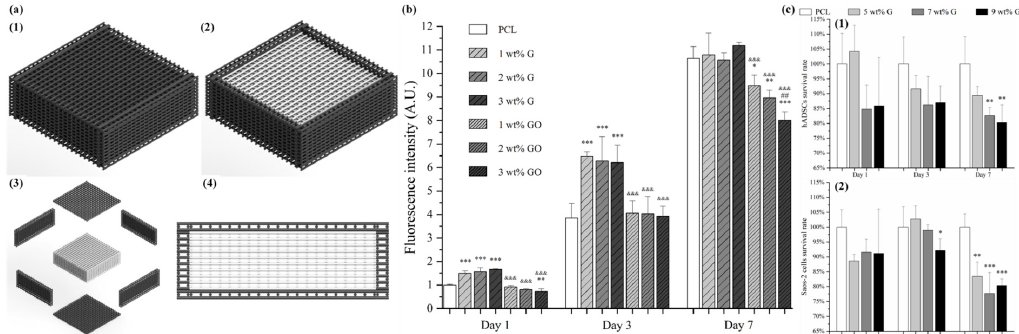
Figure 9. ( a ) Schematic drawing of dual-functional sca ff olds including overall view (with (a1) and without top (a2), exploded view (a3) and side view (a4)). ( b ) In vitro cell viability / proliferation results of PCL / graphene and PCL / GO sca ff olds with hADSCs. ( c ) Comparison test on PCL / graphene sca ff old using hADSCs (c1) and Saos-2 cells (c2) [117,118]. Reproduced with permission from Hou et